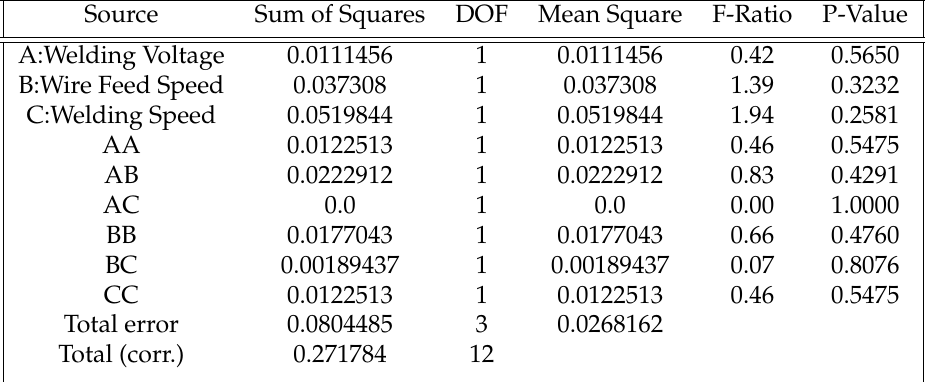
Table 7. Variance’s analysis for SQRT of Bead